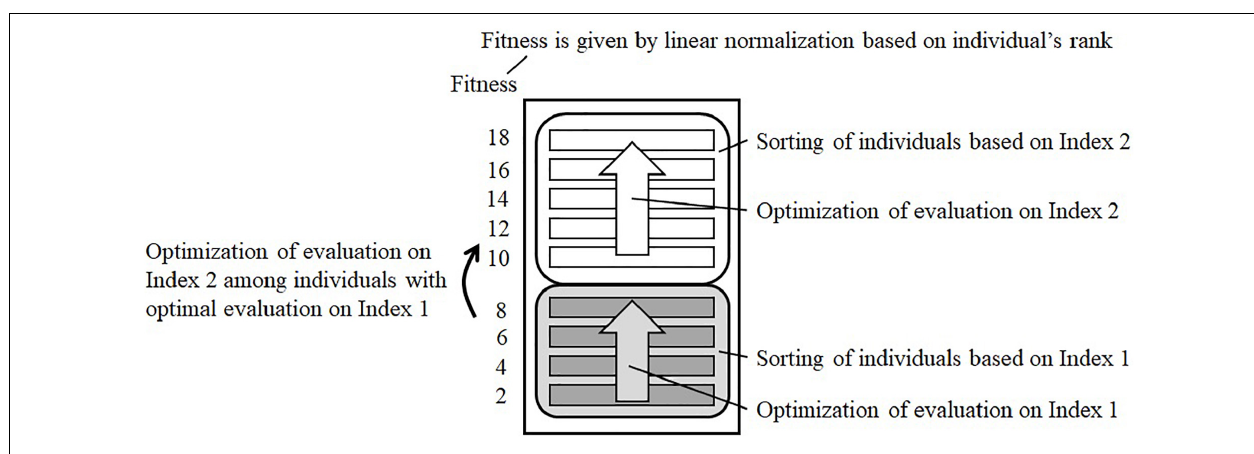
FIGURE 9 | Determination of